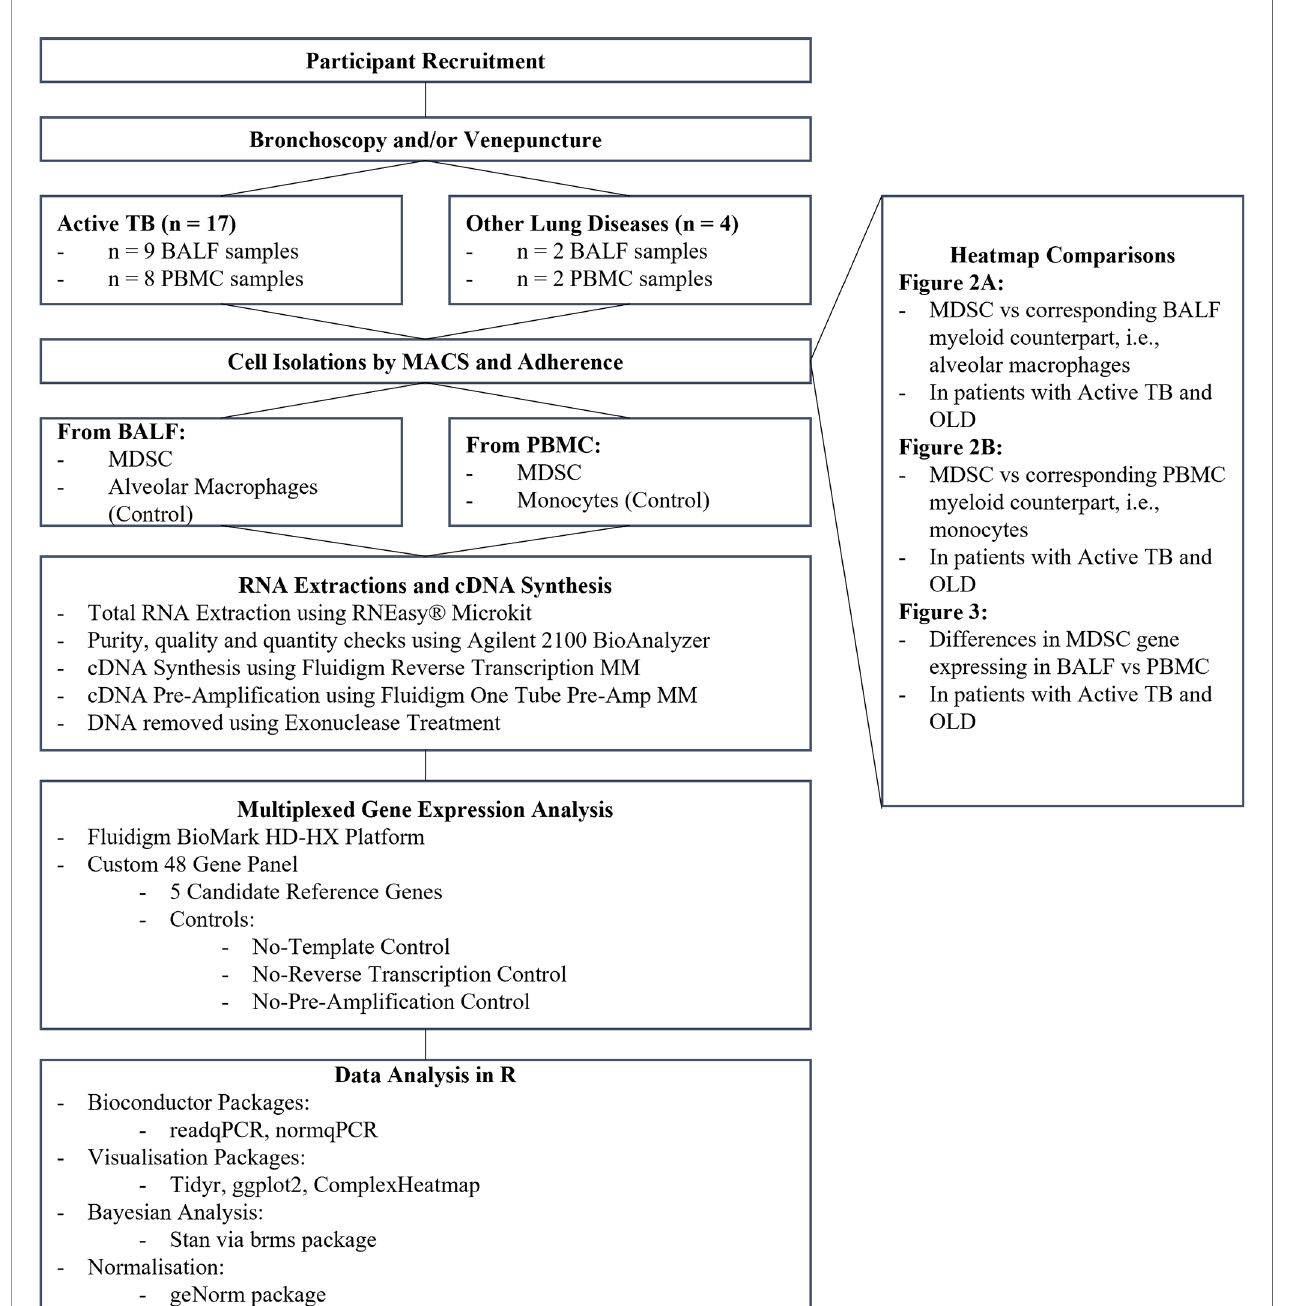
FIGURE 1 | Experimental design and work fl